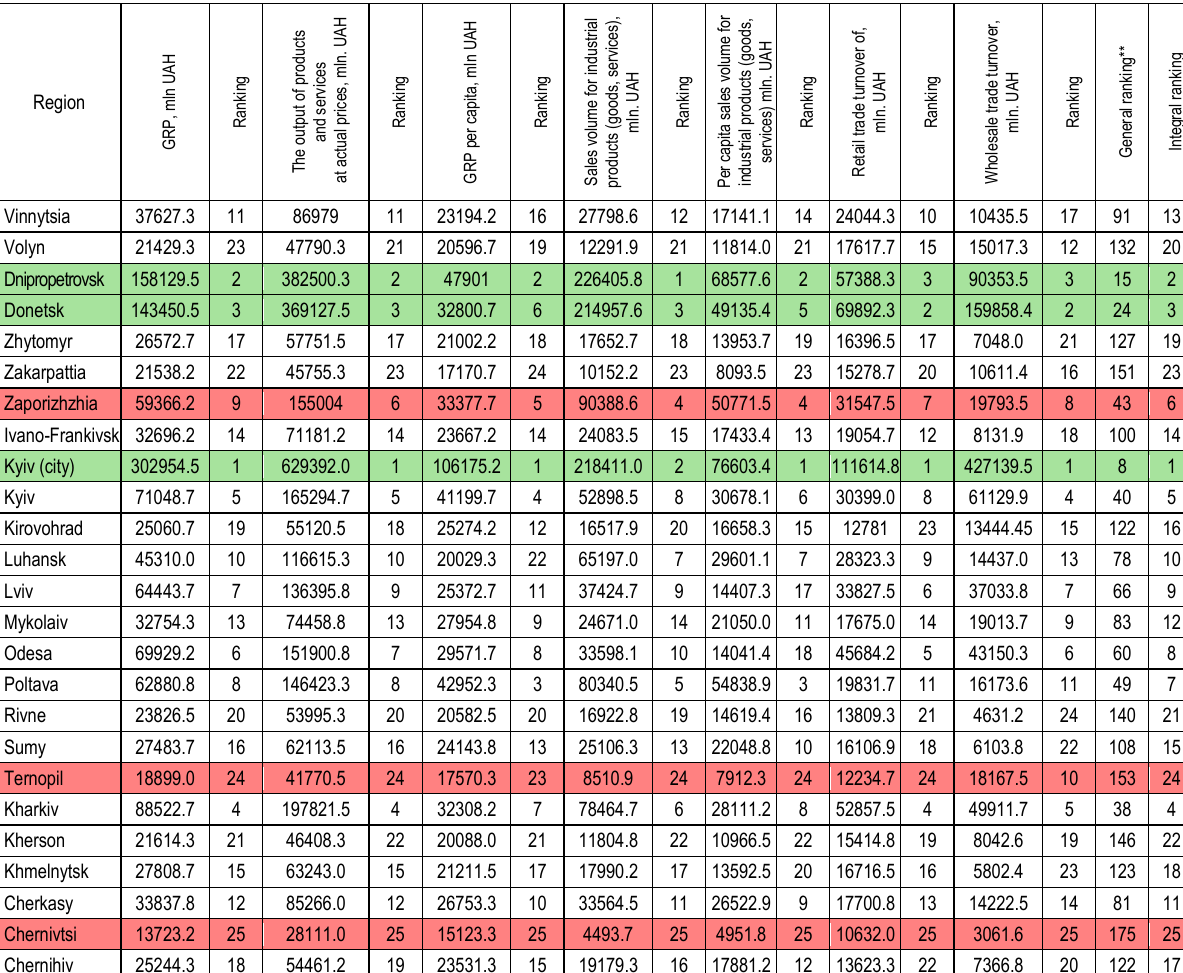
* - the lines marked in green show the best integral values of the region's indicators; and the lines marked in red show the regions with worst indicators ’ values; ** - calculated as the sum of ratings for each